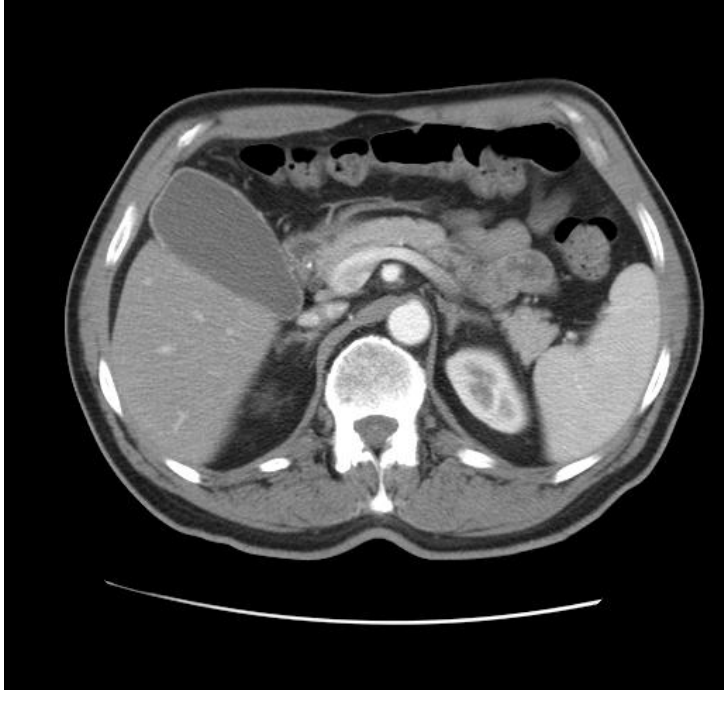
FIGURE 4. No significant change was observed in the appearance of the